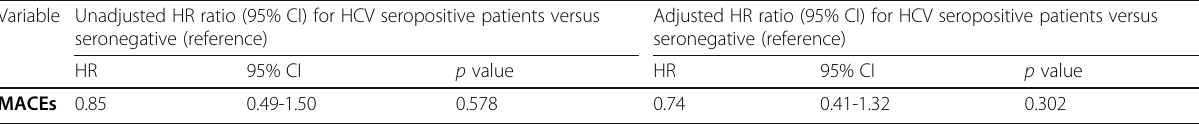
Table 7 Multivariate Cox hazard regression analyses for MACEs at 12 months follow up Variable Unadjusted HR ratio (95% CI) for HCV seropositive patients versus seronegative (reference)